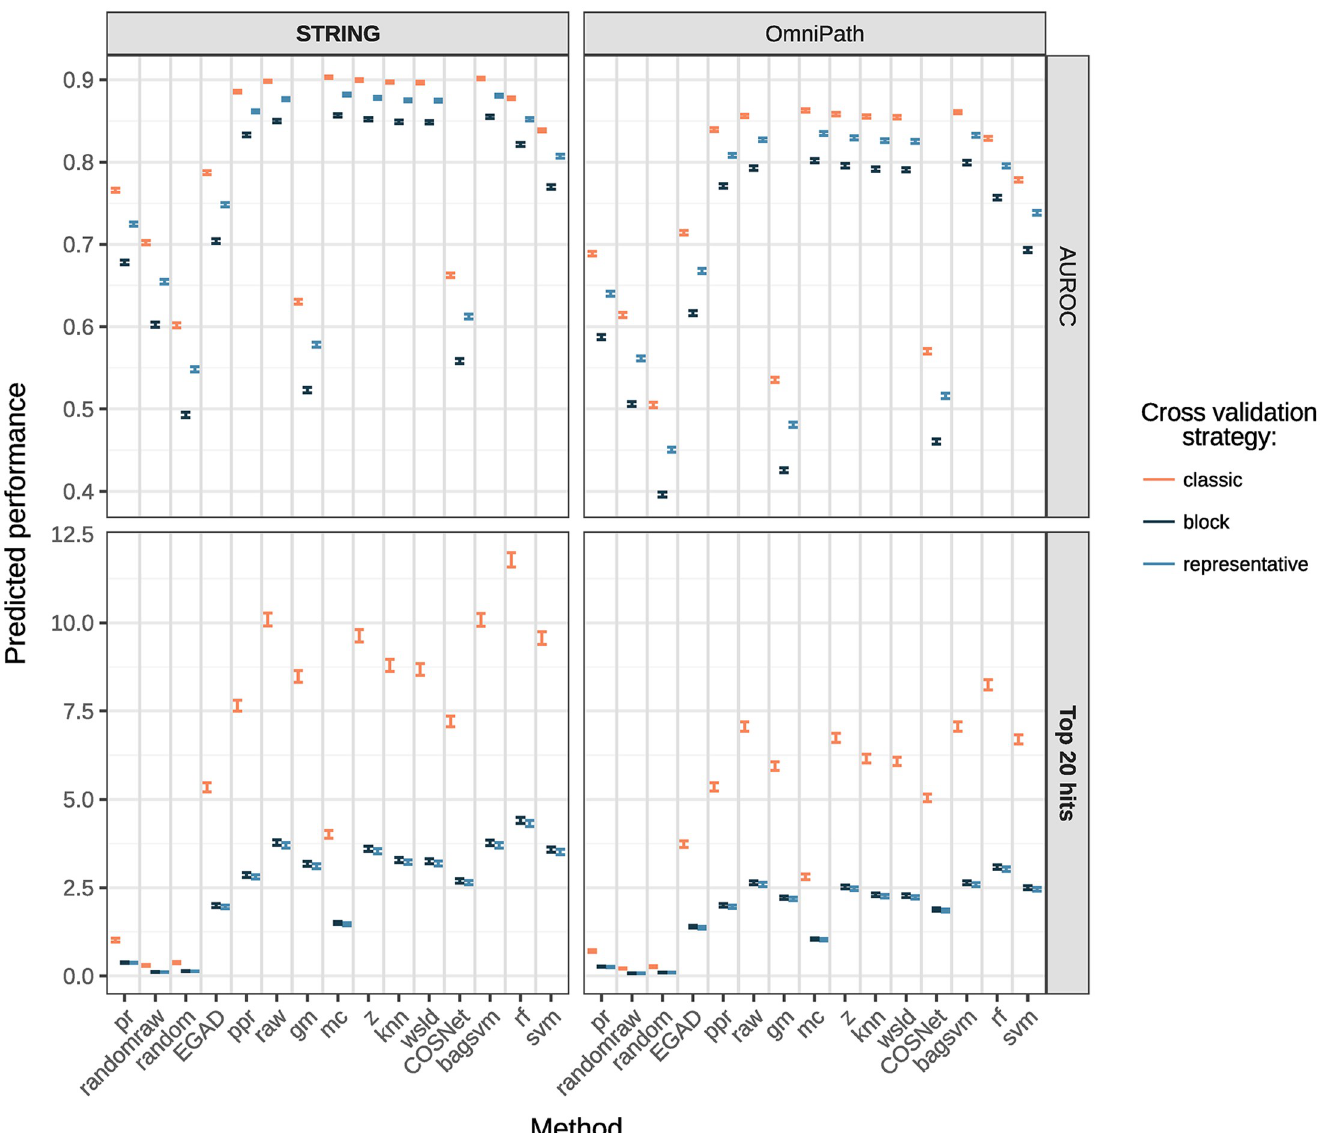
Fig 3. Performance predicted for AUROC and top 20 hits through the additive explanatory models. Each row corresponds to a different model and error bars depicts the 95% confidence interval of the additive model prediction, averaging over diseases. In bold, the main network (STRING) and metric (top 20 hits). The exact values can be found in Table I in S1